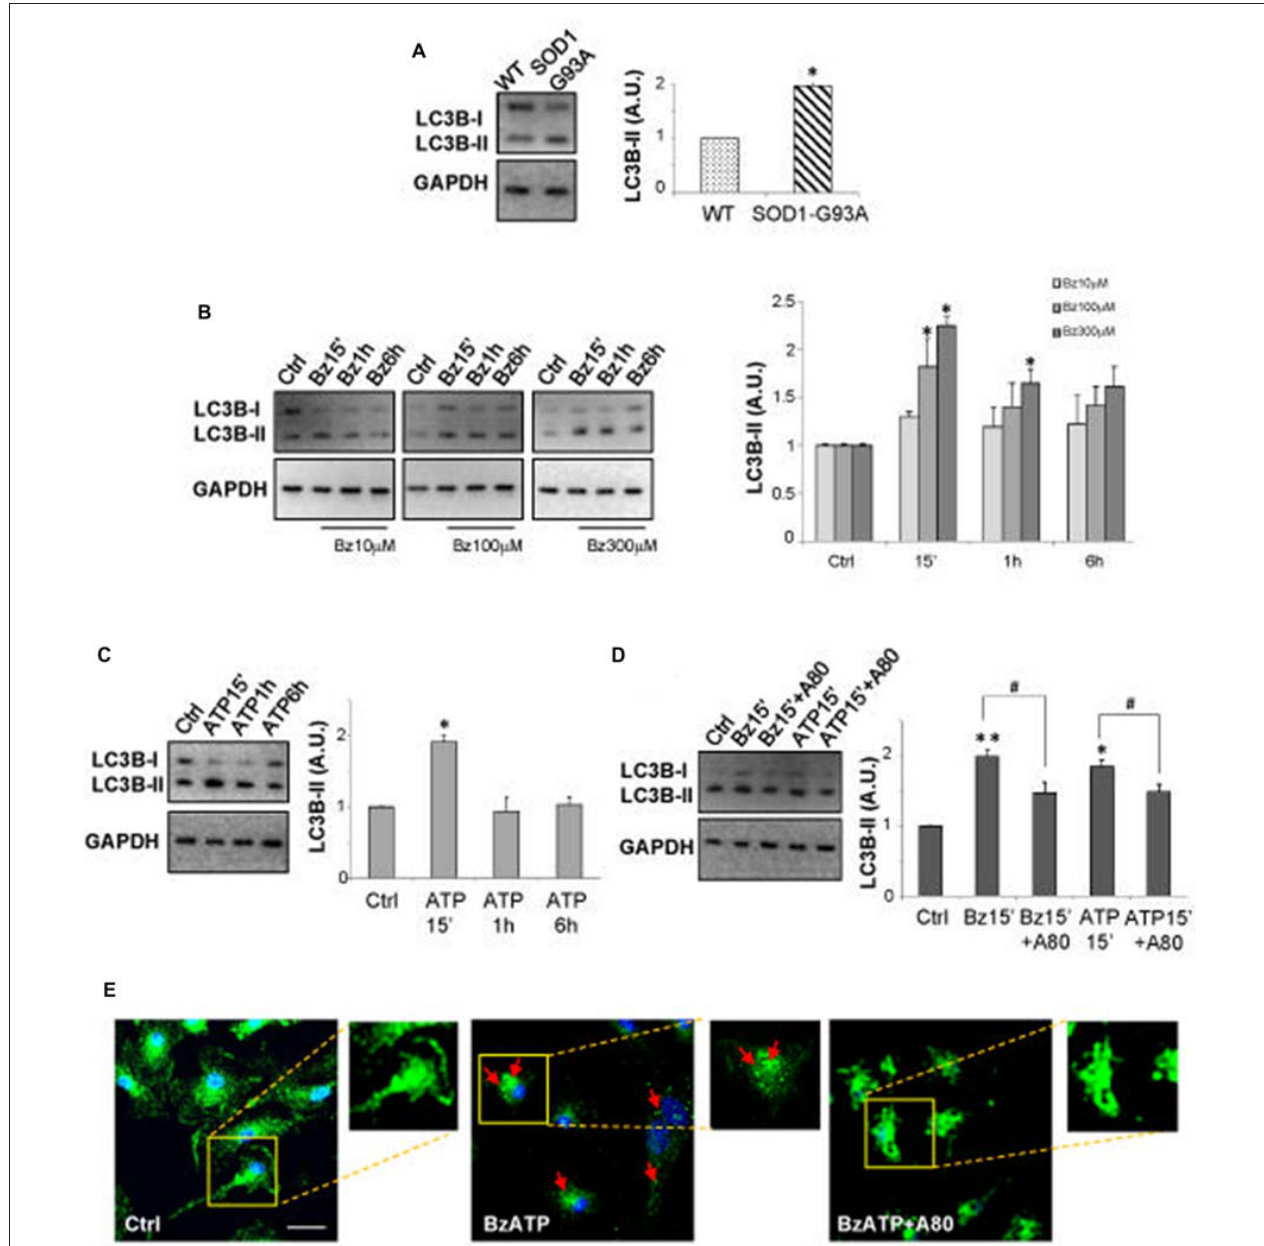
FIGURE 1 | P2X7 activation modulates microtubule-associated protein 1 light chain 3 (LC3)-II in superoxide dismutase 1 (SOD1)-G93A microglia. (A) Equal amounts of total protein from wild-type (WT) and SOD1-G93A primary microglia were subjected to western blotting and immunoreactions with anti-LC3B-II and anti-GAPDH to normalize proteins. (B–D) Equal amounts of total protein from SOD1-G93A primary microglia were subjected to western blotting and immunoreactions with anti-LC3B-II and anti-GAPDH. In (B) , cells were exposed to 10–100–300 µ M 2 (cid:48) -3 (cid:48) -O-(benzoyl-benzoyl) ATP (BzATP) for 15 min, 1 h or 6 h. In (C) cells were exposed to 3 mM ATP for 15 min, 1 h or 6 h. Cells were treated for 15 min with 300 µ M BzATP or 3 mM ATP, in the absence or presence of 10 µ M A-804598 (D) . (E) SOD1-G93A microglia treated with 300 µ M BzATP in the absence or presence of 10 µ M A-804598 were analyzed by means of fluorescence microscopy after staining with anti-LC3B (arrows indicate LC3 vacuoles; scale bar 50 µ m; nuclei in blue). Data represent mean ± SEM of n = 3 independent experiments. Statistical significance was calculated by student’s t -test or Mann-Whitney rank sum test or analysis of variance (ANOVA) followed by Post Hoc Tukey’s test, and referred to WT (A) or Ctrl (B–D) ( ∗ p < 0.05, ∗∗ p < 0.01); to BzATP15’-treated cells or ATP15’-treated cells ( # p < 0.05).